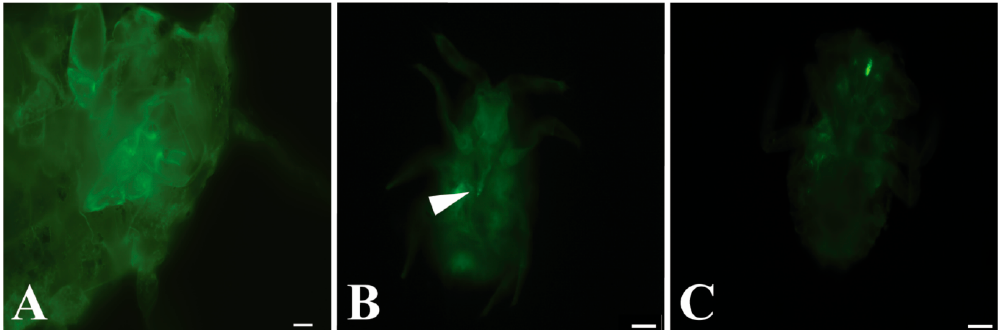
Figure 1. GLRaV-3 virions are retained in the mouthparts of P. ficus vectors. ( A ) First instar head of P. ficus control after feeding on membrane diet containing sucrose without virions followed by subsequent antibody labeled diets showing no labeling. Chitin in insects can be autofluorescent, accounting for the small signal observed. ( B ) Retention of GLRaV-3 virions in the retracted stylet tips (near white arrow) or ( C ) cibarium of P. ficus after sequential membrane feeding immunolocalization assay. Bars represent 20 µ m. Table 2. Summary of GLRaV-3 retention site observations. Planococcus ficus fed on either artificial diet augmented with GLRaV-3 virions or vine cuttings for 12 h, followed by 12-h acquisition access times on diets containing anti-GLRV-3 polyclonal antisera and antisera conjugated with Alexa Fluor 488, respectively.